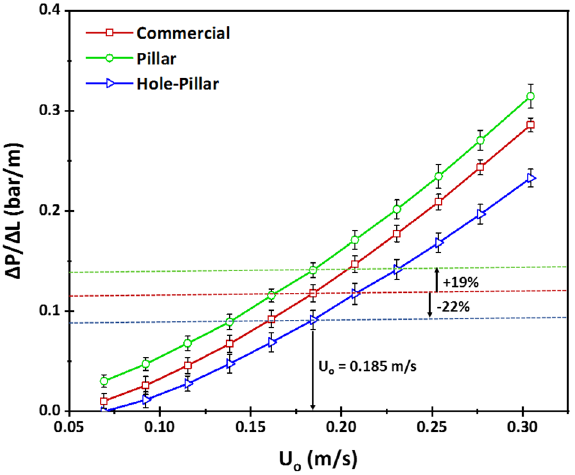
Figure 3. Experimental pressure drop gradients along the filtration channel length as a function of various inlet velocities for the three tested spacers. The lowest pressure drop is observed for hole-pillar spacer, followed by commercial and then pillar spacers.